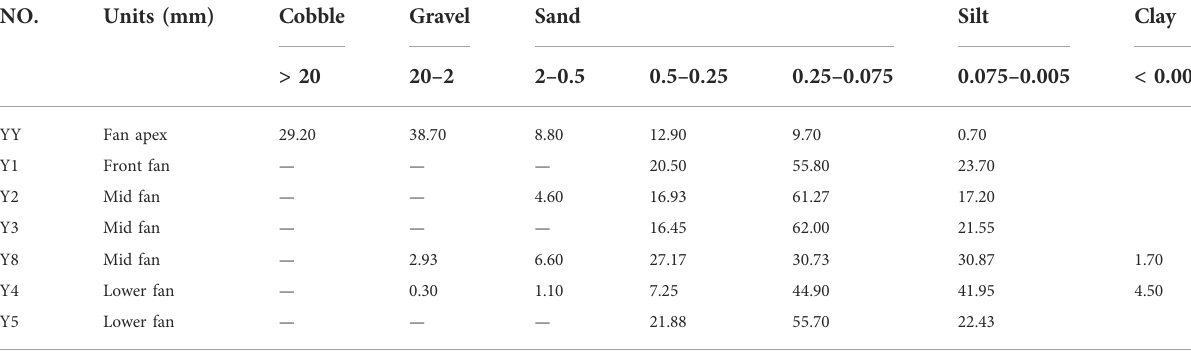
TABLE 2 Grain-size distribution in the Yongding River alluvial fan.